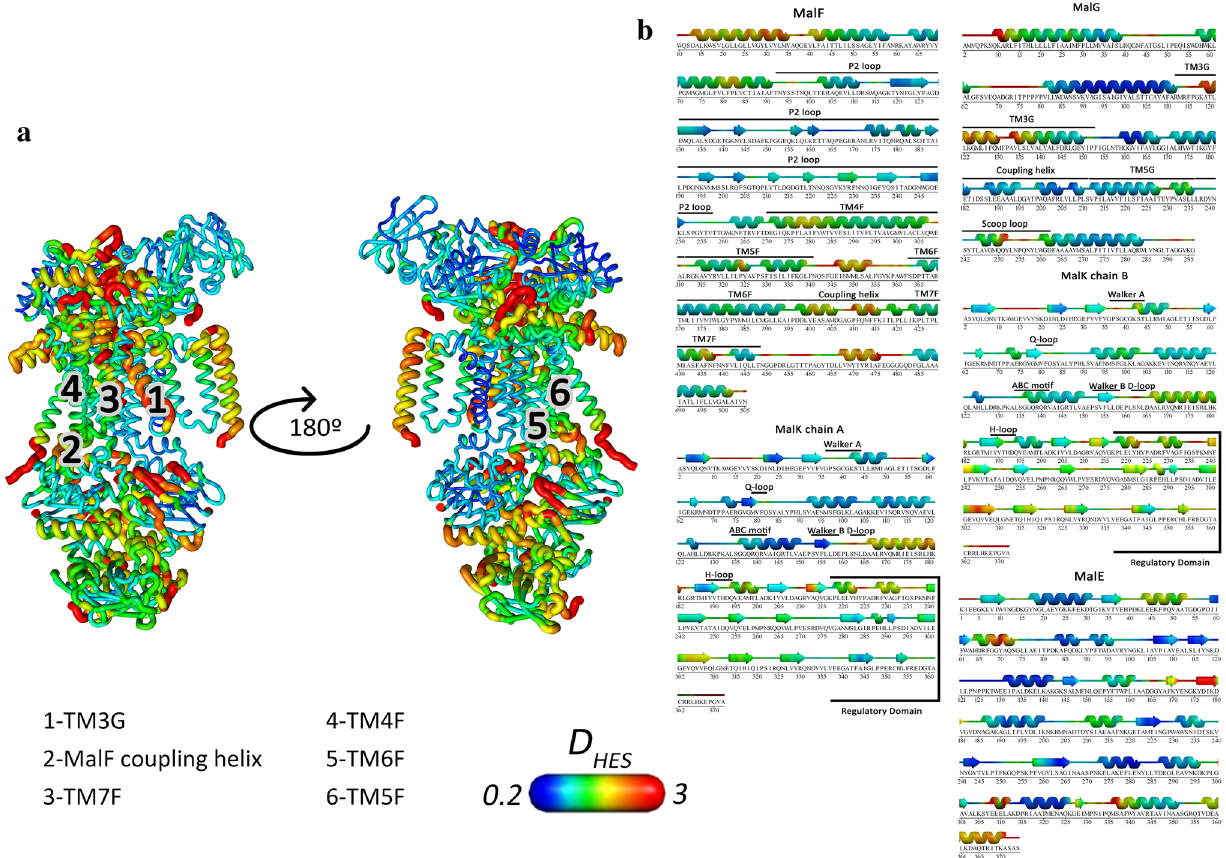
Figure 3. Mapping of the harmonic ensemble similarity (D HES ) between the ATP and ADP states. D HES was calculated for each residue, using the C-α atoms. The last 50 ns of each trajectory were used for this analysis, and the values presented result from the average of cross-replicate comparisons. The scale below indicates the magnitude of the changes in D HES observed, in which the dark blue corresponds to the minimum values observed, indicating increased similarity while the red corresponds to the maximum values observed, indicating increased dissimilarity. ( a ) D HES values mapped on the protein structure. The structure in the left represents the “front view” of the transporter, while the one on the right represents the “rear view”, accomplished by a 180° rotation. Relevant regions are marked with numbers: 1-Transmembrane helix 3 MalG (TM3G), 2-MalF coupling helix, 3-Transmembrane helix 7 MalF (TM7F), 4- Transmembrane helix 4 MalF (TM4F), 5-Transmembrane helix 6 MalF (TM6F), 6-Transmembrane helix 5 (TM5F). ( b ) Mapping of D HES between the ATP and ADP states, on the sequence of each chain. The 3D structure map was obtained with PDBsum 68